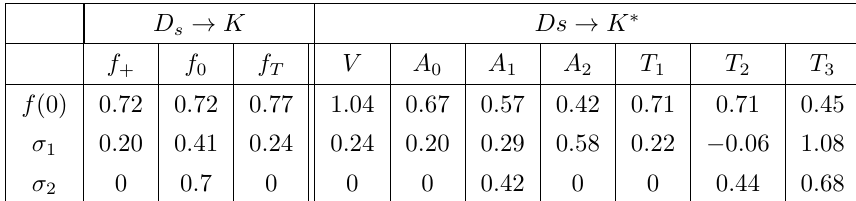
Table 17 . Part II: Best-(cid:12)t parameters for D s decays from ref.